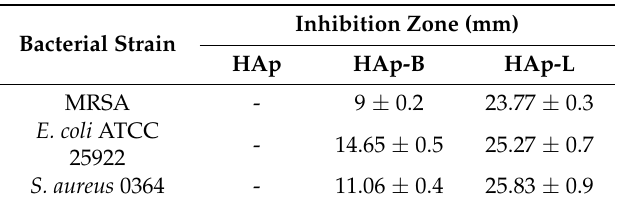
Table 4. Inhibition zone diameters of HAp, HAp-B and HAp-L samples against MRSA, S. aureus 0364 and E. coli ATCC 25922 bacterial strains. Inhibition Zone Bacterial Strain